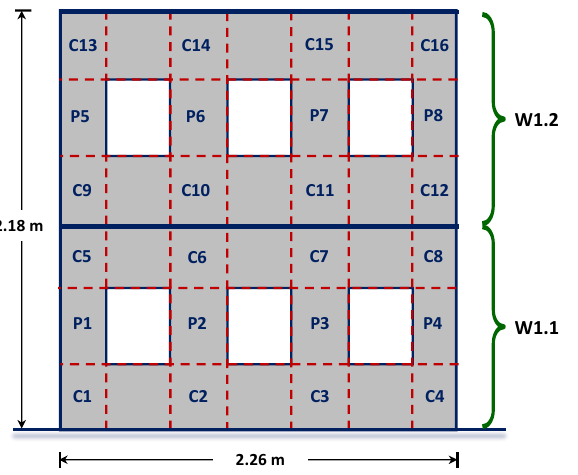
Figure 12. The discretization of the considered wall façade by using panels from the study of Ref [50]. Table 2. Comparison of expected and actual failure modes of the URM wall.